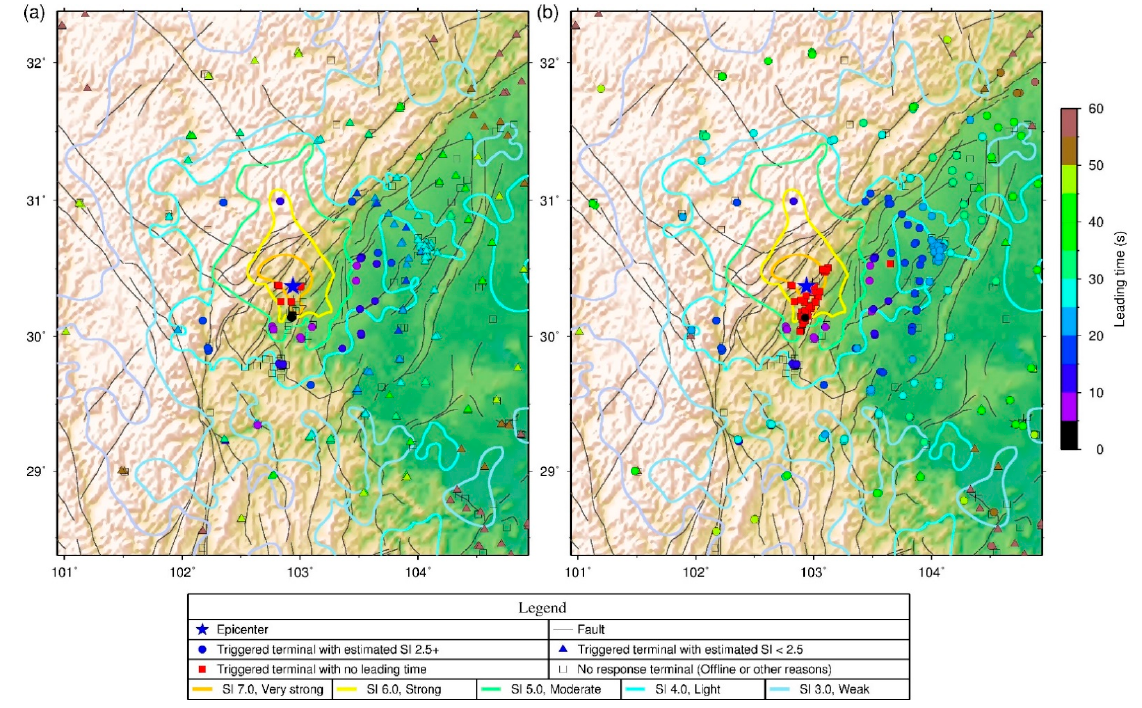
Figure 7. Leading time maps for the ( a ) first and ( b ) final early-warning alerts during the 2022 M 6.1 Lushan earthquake, with simplified contours of peak observed SI (colored lines). The contour lines were obtained using ‘surface’ and ‘grdcontour’ commands in the Generic Mapping Tools (GMT) software (Version 6.1.1, developed by Wessel, P. and Smith, W.H.F., https://www.generic-mapping- tools.org/, accessed on 20 July 2022) from [43].